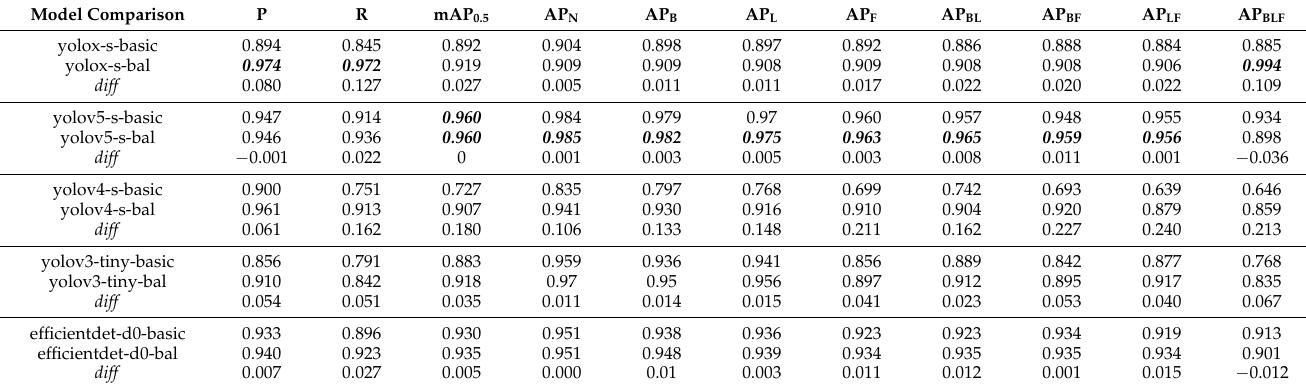
Table 5. Detection results of different models on the test